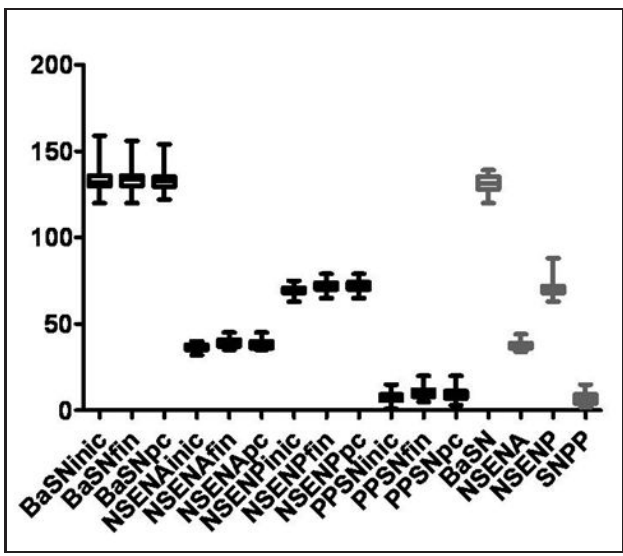
Fig. 1 - Values of BaSN, NSENA, NSENP and SNPP angles in the treated group at the time intervals before treatment (T minimum of 5 years post-retention (T